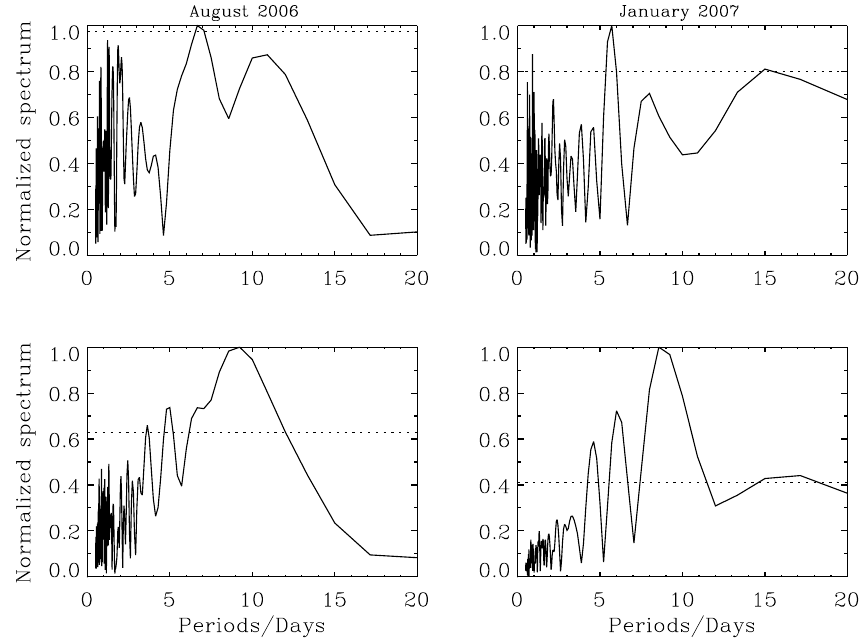
Fig. 11. Normalized frequency spectra of the time series of the tropospheric (bottom row) and lower stratospheric (top row) GW energy densities in August 2006 (left column) and January 2007 (right column). The horizontal dotted lines denote the 90% significance